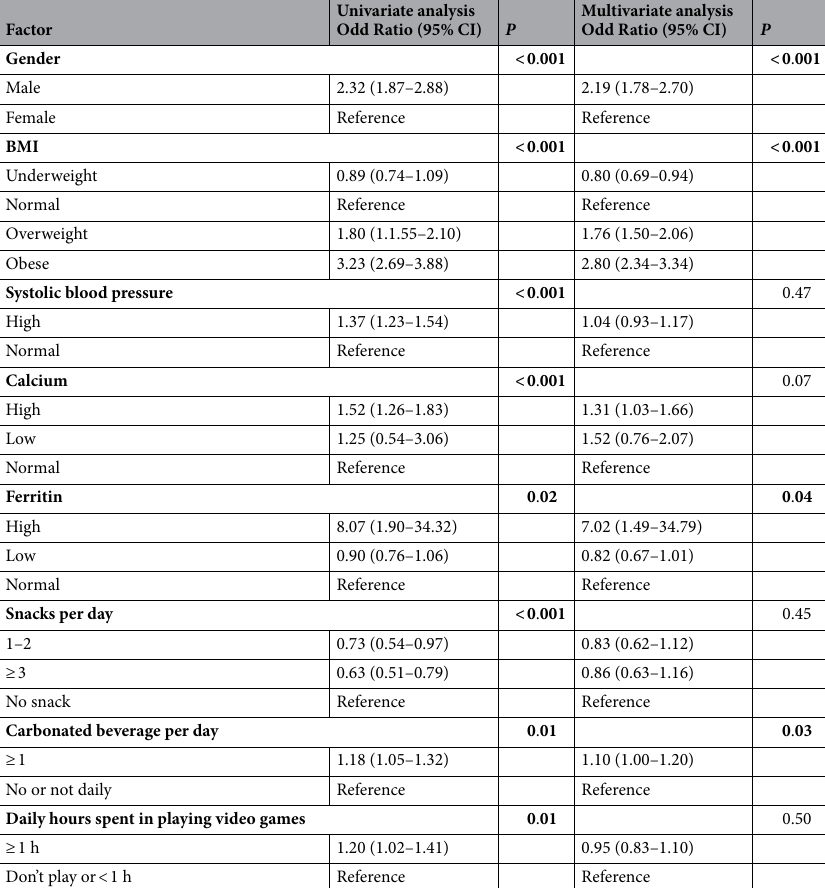
Table 4. Univariate and multivariate logistic regression analysis model for variables associated with dyslipidemia. 95% CI 95% confidence interval, BMI body mass index, P P value (Wald test). Significant values are in